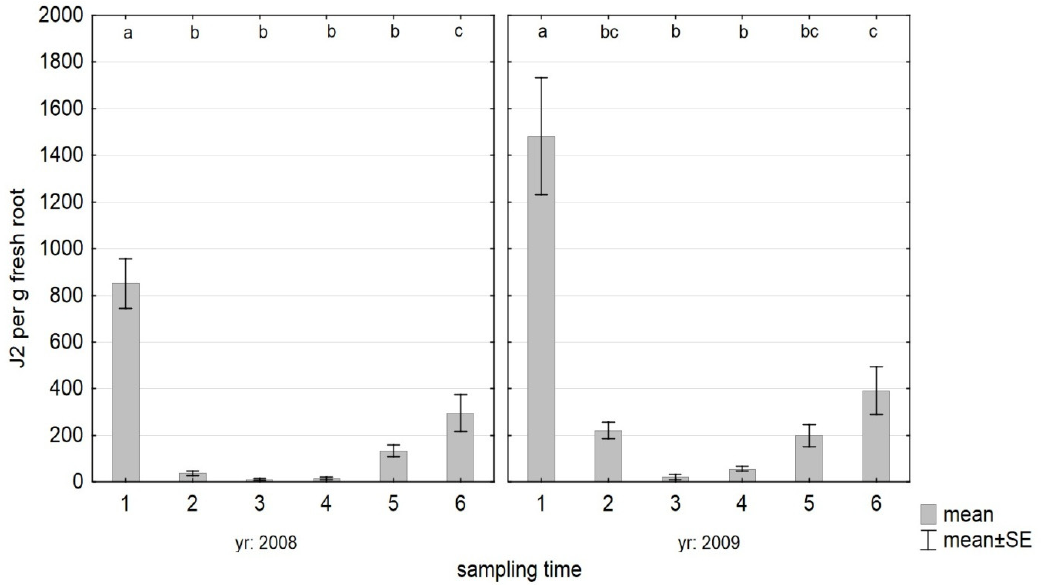
Figure 1. Population dynamics of beet cyst nematode (BCN) juveniles (J2) in oilseed rape OSR roots at six sampling dates after sowing, referring to degree days (>8 °C) in the year 2008: 135 DD (date 1), 225 (2), 324 (3), 396 (4), 441 (5), 522 (6) and in the year 2009: 123 (1), 199 (2), 318 (3), 405 (4), 456 (5), 550 (6); means only within years were tested by Fischer LSD Test ( p < 0.05), different letters indicate significant differences.